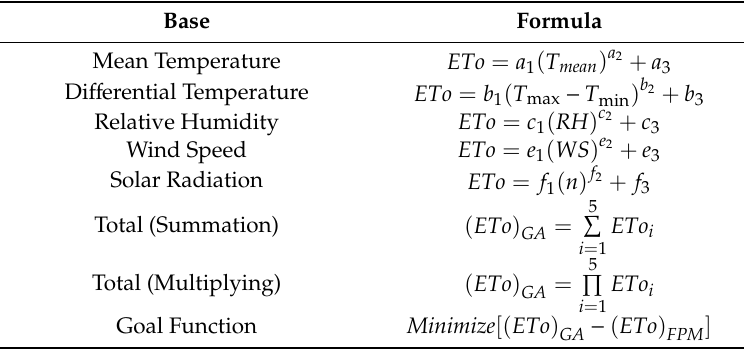
Table 1. Structure of genetic algorithm (GA) designed in this study.